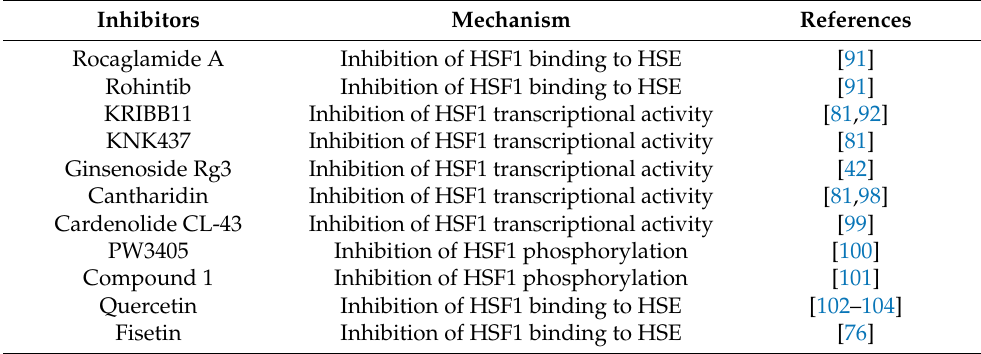
Table 4. HSF1 inhibitors in